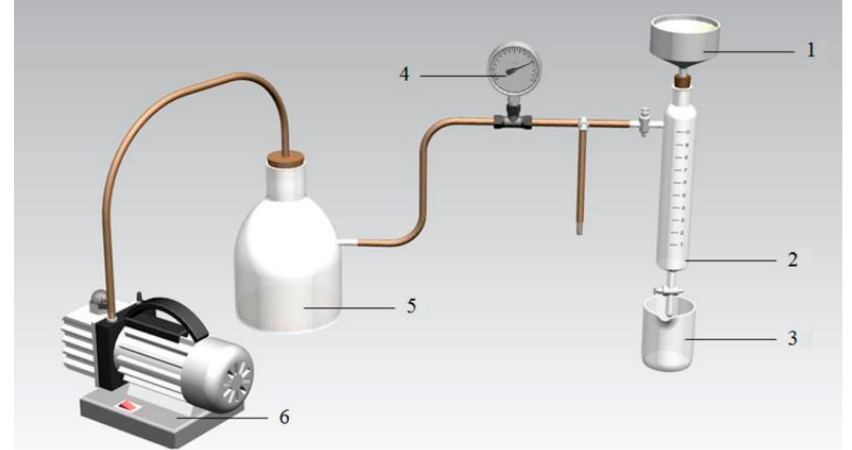
Figure 2. Büchner funnel filtration equipment [18]. 1—Büchner funnel; 2—Filter tube; 3—Filtratre collector; 4—Vacuum pressure gauge; 5—Buffer bottle; 6—Vacuum pump. (Reproduced with permission from Fan et al. [37]; published by Elsevier,